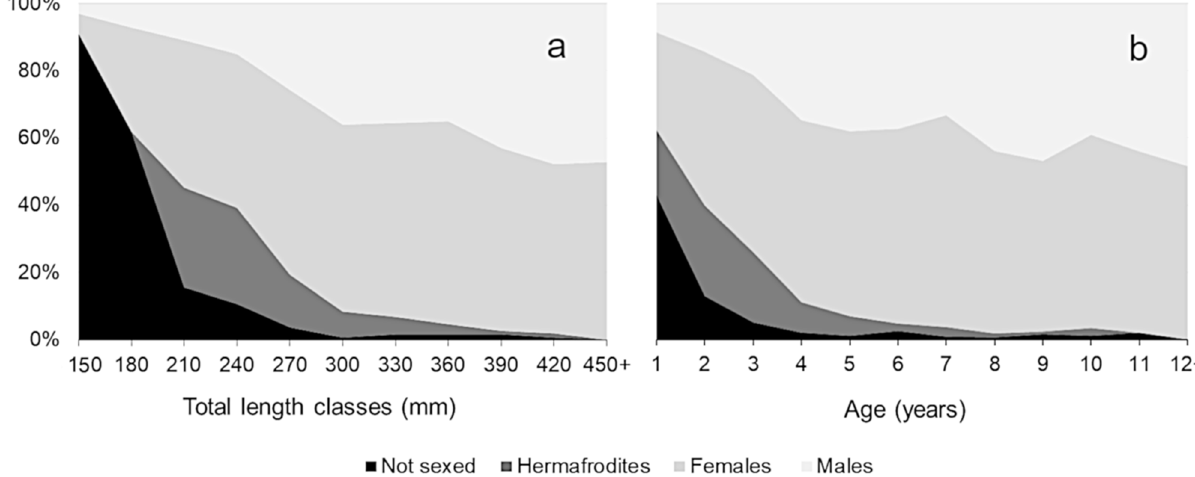
Fig. 11. Sex ratio by (a) total length classes of 30 mm intervals ( n = 2907) and (b) by age classes ( n =2228) of Pagrus pagrus sampled in Rio Grande from 1976 to 1985. Table 6. Length – age key of Pagrus pagrus from southern Brazil sampled between 1976 and 1985. TL total length in mm. TL